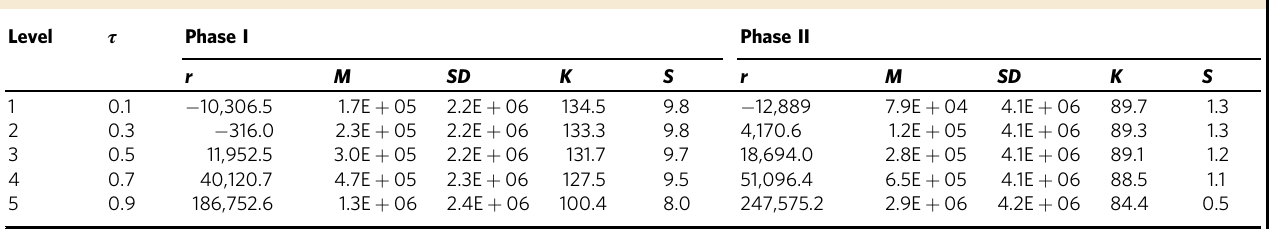
Table 1 De fi nitions and statistics of the